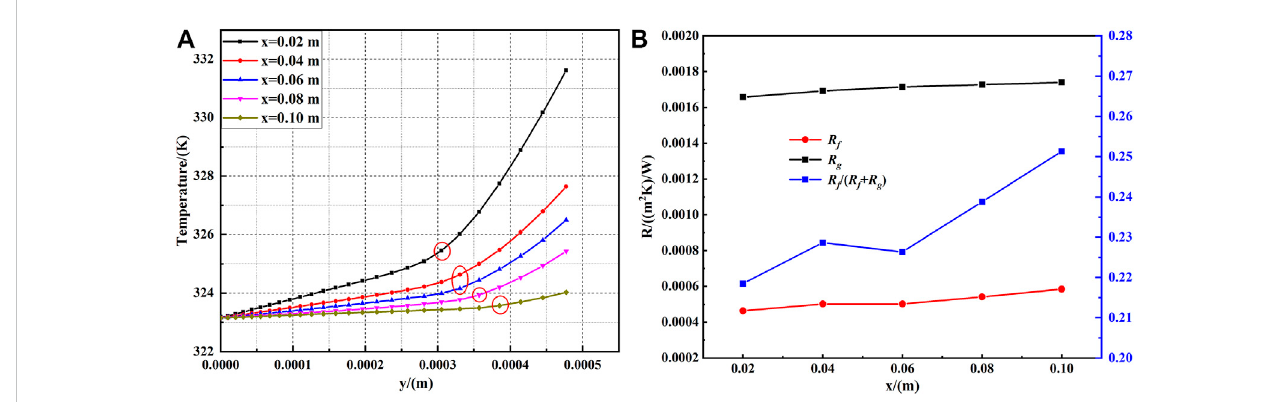
FIGURE 14 Heat transfer analysis in Case 3: (A) temperature distribution near the wall; (B) thermal resistance pro fi